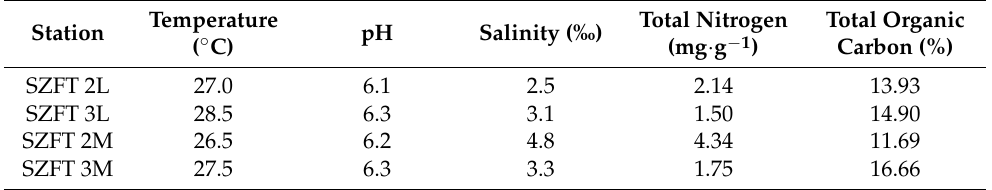
Table 1. Characteristics of surface sediments of sampling